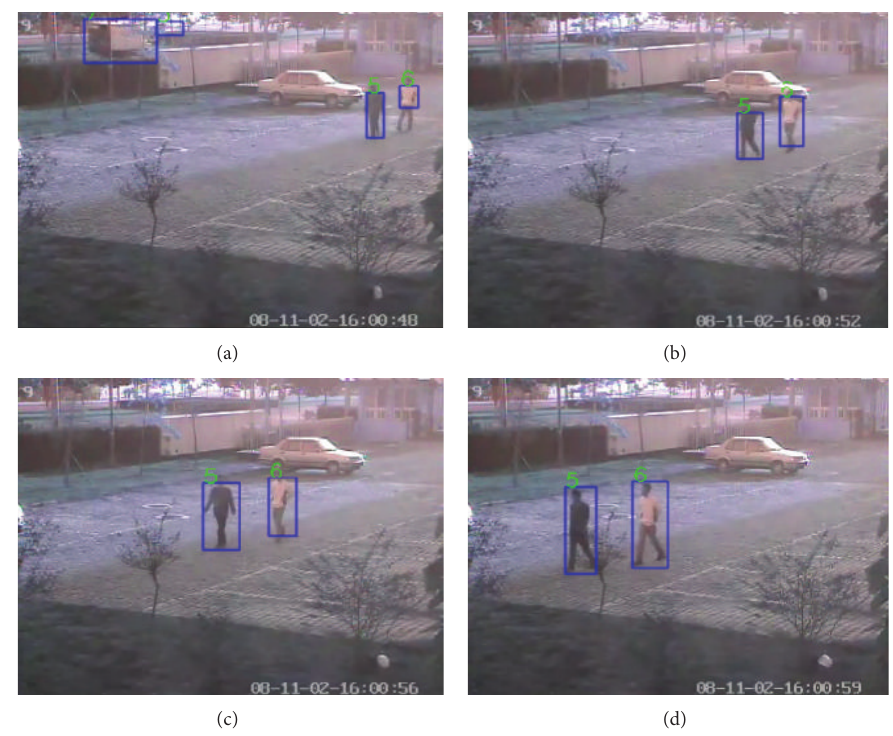
Figure 5: The target tracking results of video data